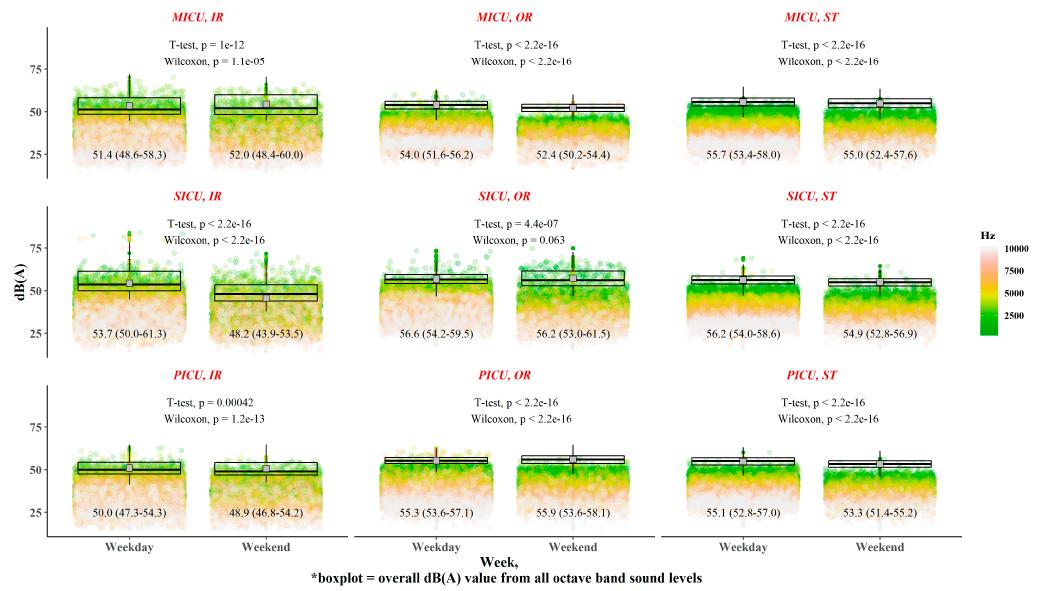
Figure 3. Noise exposure levels on weekdays versus weekends. Note: The boxplot indicates differences in overall sound pressure level (dBA) values for all octave band sound levels.